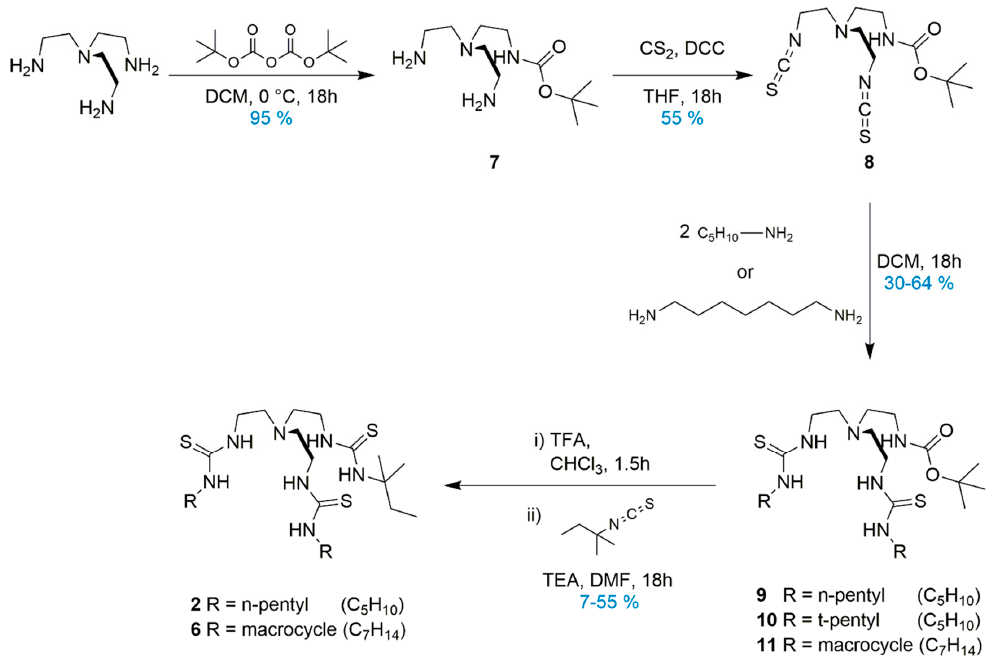
Figure 2. Scheme of the synthetic procedure for unsymmetrical and macrocyclic tren-based thiourea receptors.